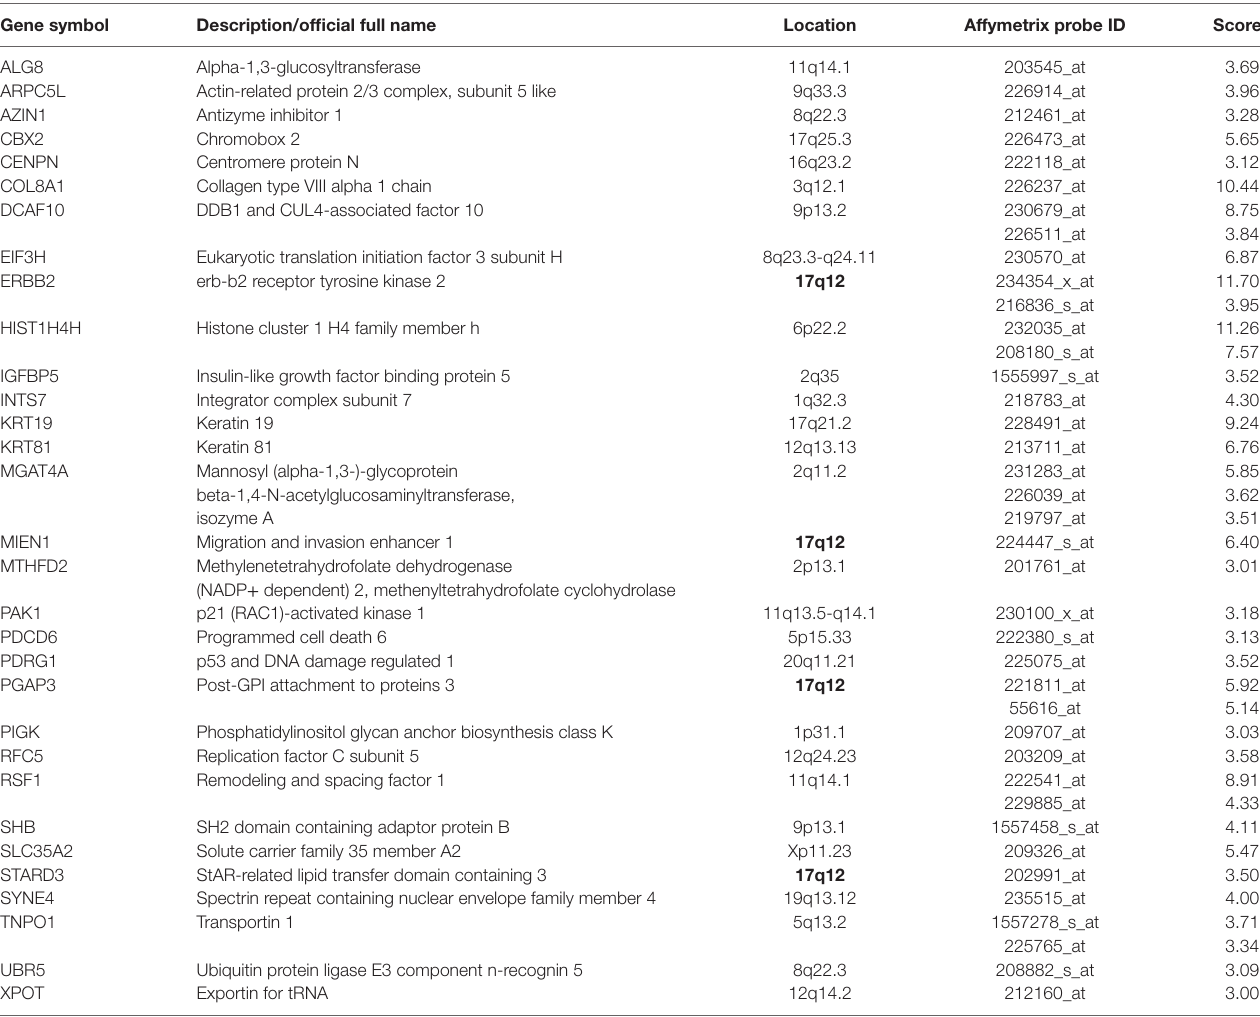
TaBle 4 | In silico verified candidate TAAs. gene